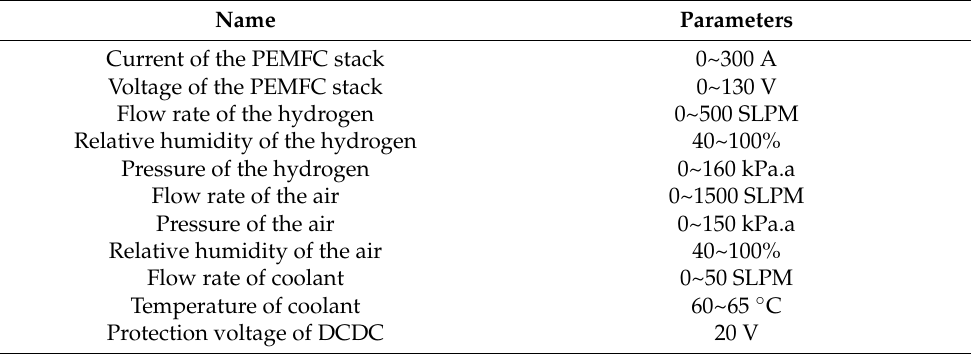
Table 2. The parameters of the PEMFC system testbench.